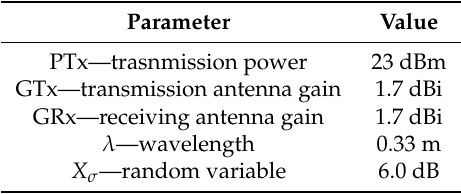
Table 7. Frequencies and respective